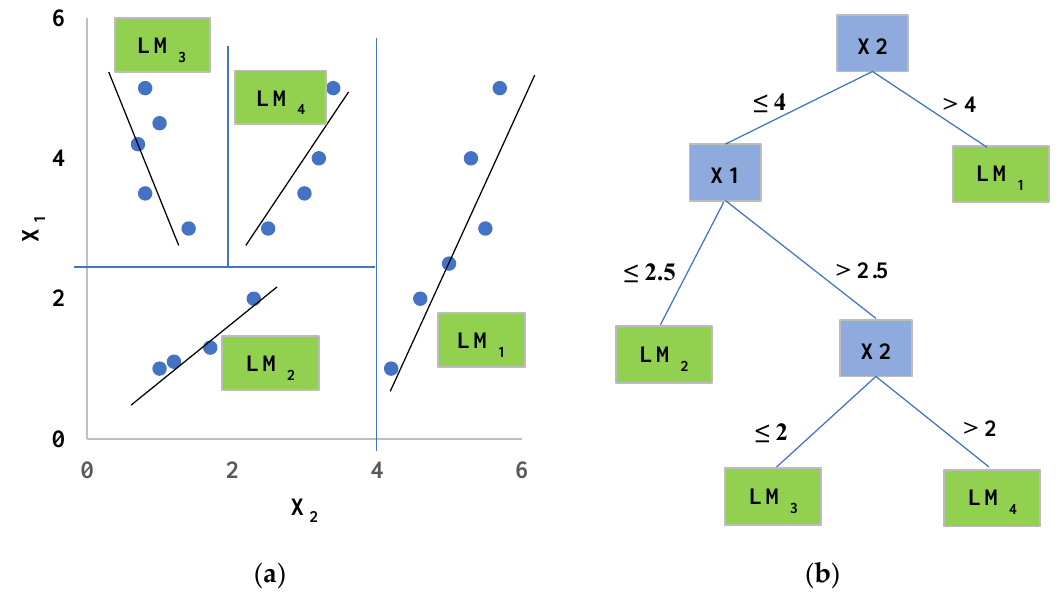
Figure 3. The M5 model regression tree (M5RT) model for wind speed/power prediction. LM indicates linear model in the figure. ( a ) splitting the input space X1 x X2 by M5RT algorithm; ( b ) diagram of model tree with four linear regression models at the leaves.